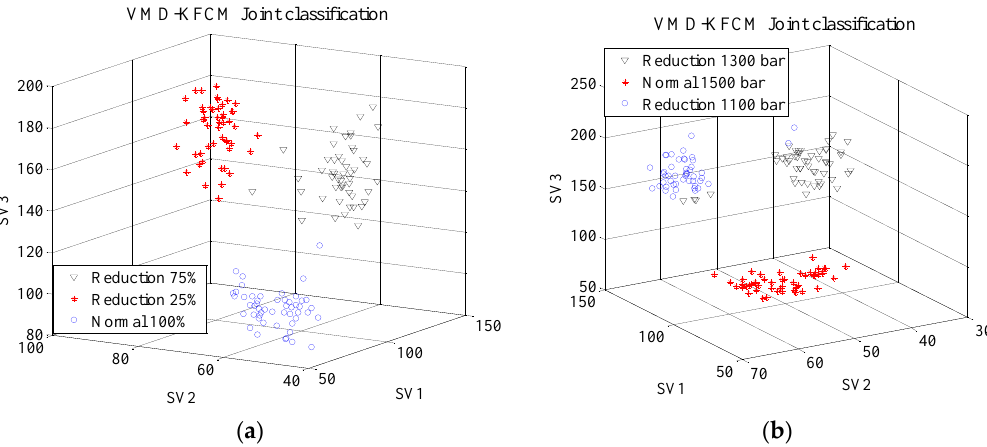
abnormal valve clearance signals using singular value as feature vector. valve clearance signals using singular value as feature vector.